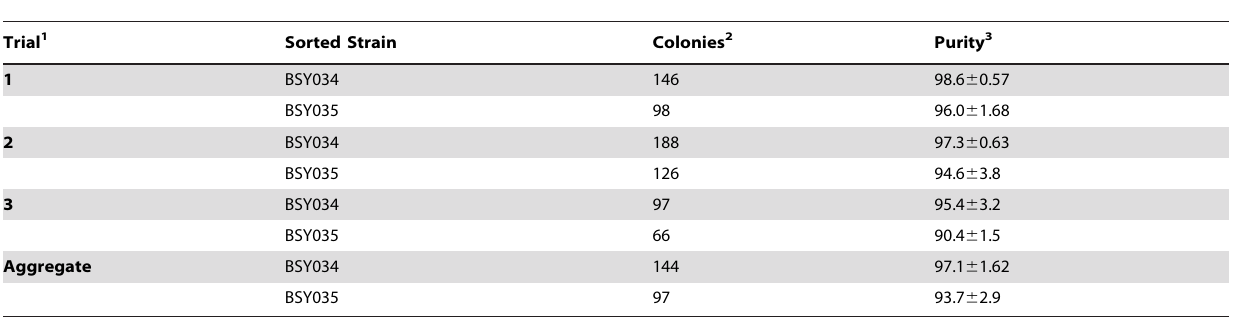
Table 3. Sorting Data.